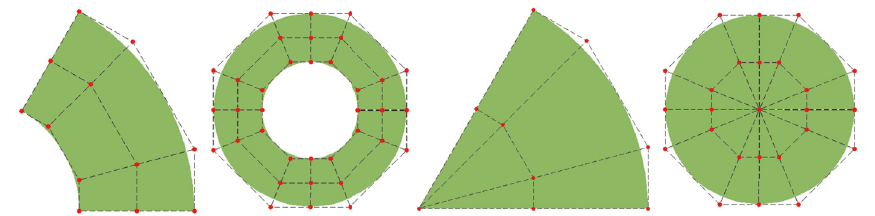
Figure 2: The exact geometries and control nets for sector plates of various types.